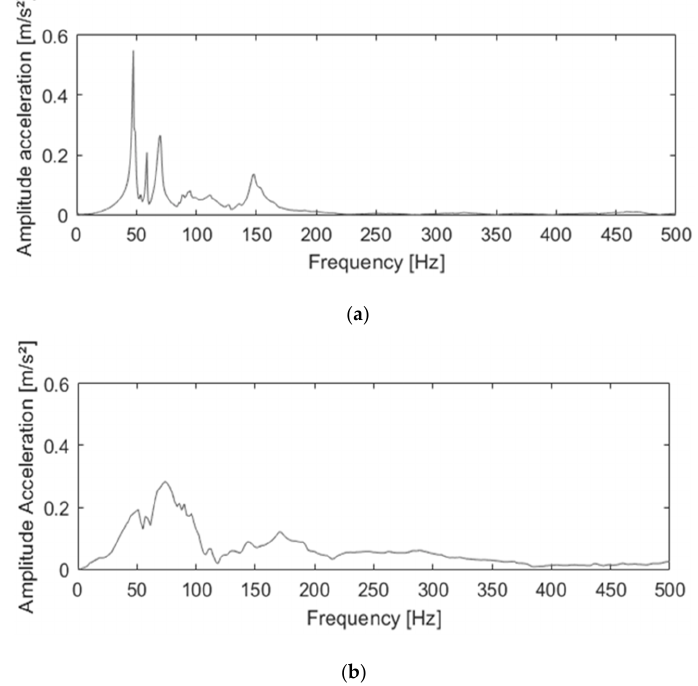
Figure 3. Frequency response in the vertical direction without a cyclist ( a ) and with a cyclist ( b ).